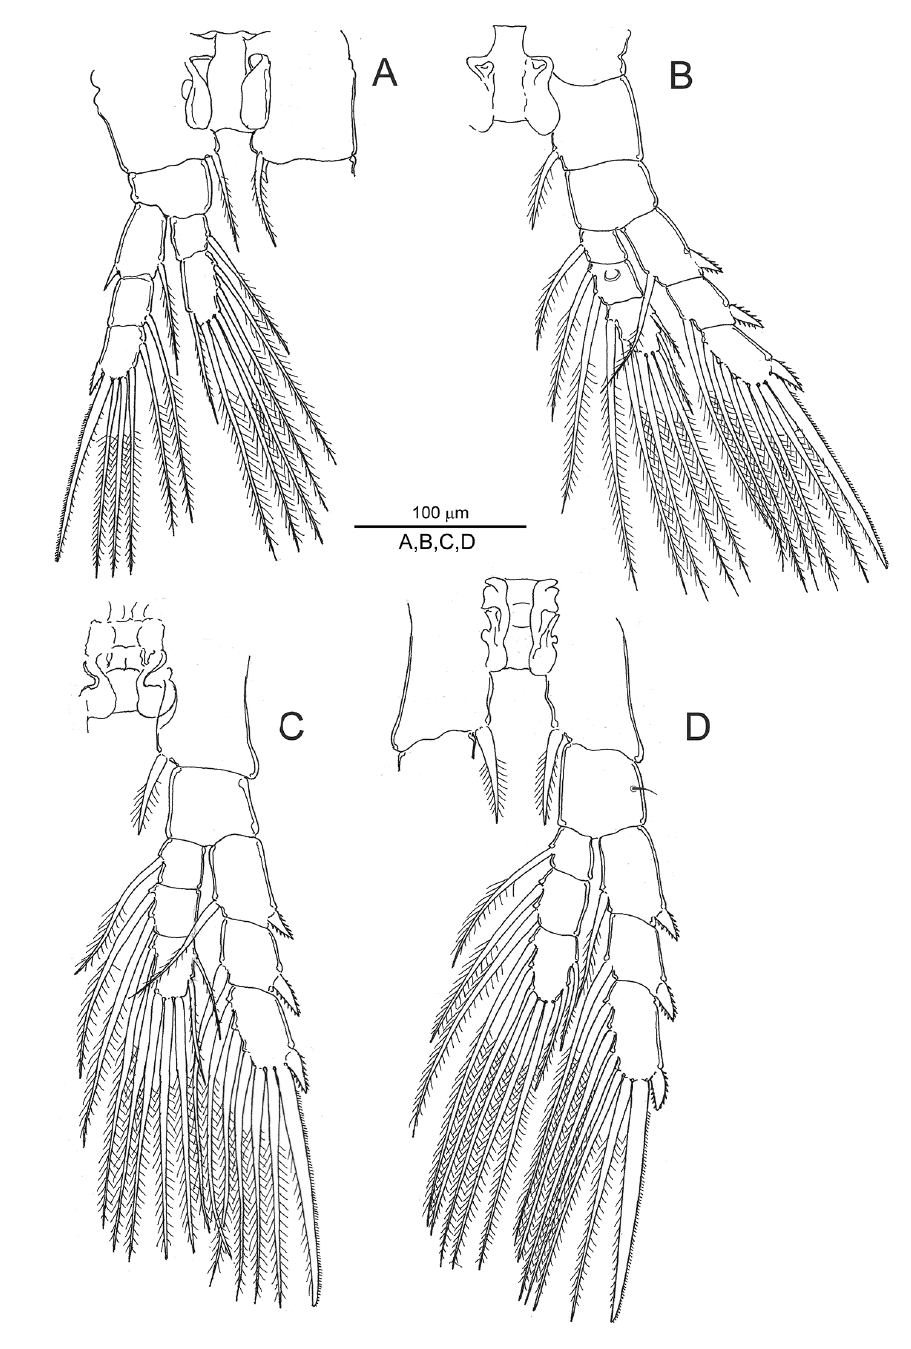
Figure 4. Notodiaptomus cannarensis sp. n., adult female. A left leg 1, posterior view B right leg 2, pos- terior C left leg 3, anterior D right leg 4,